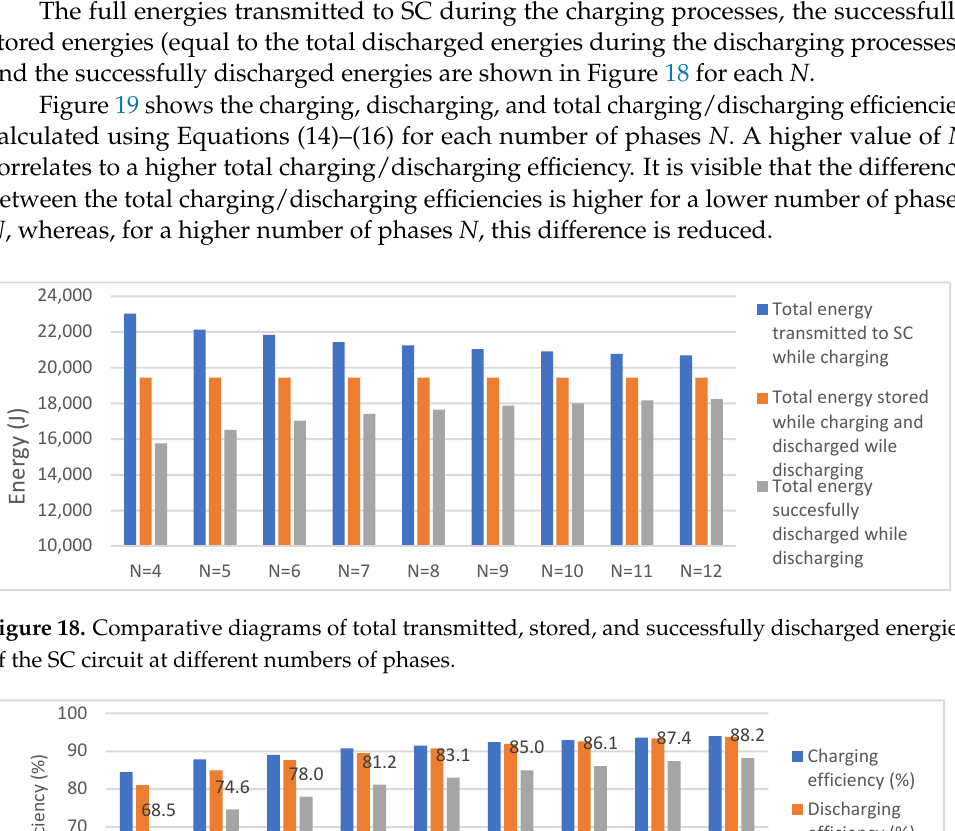
Figure 17. Comparative diagrams of total energies lost during charging and discharging of the SC circuit at different numbers of phases.